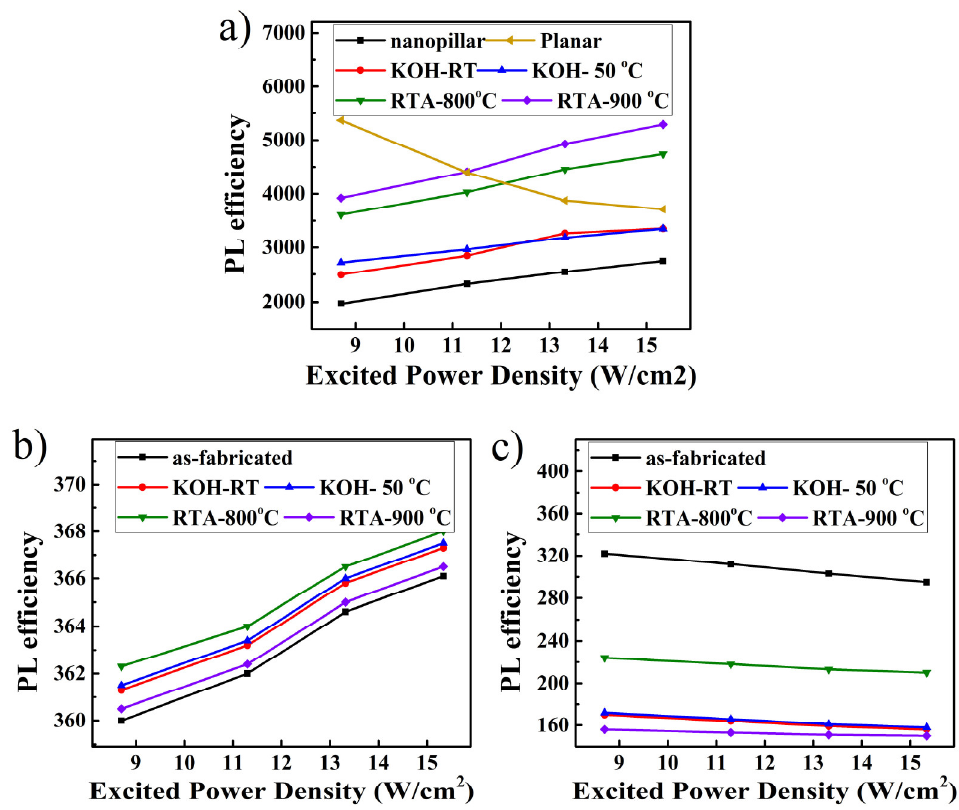
Figure 5. PL e ffi ciency as a function of excited power density for III-polar nanopillar MQWs ( a ), and N-polar nanopillar MQWs with emission wavelength located at 386 nm ( b ) and at 420 nm Micromachines 2019 , 10 , x FOR PEER REVIEW ( c ) respectively.